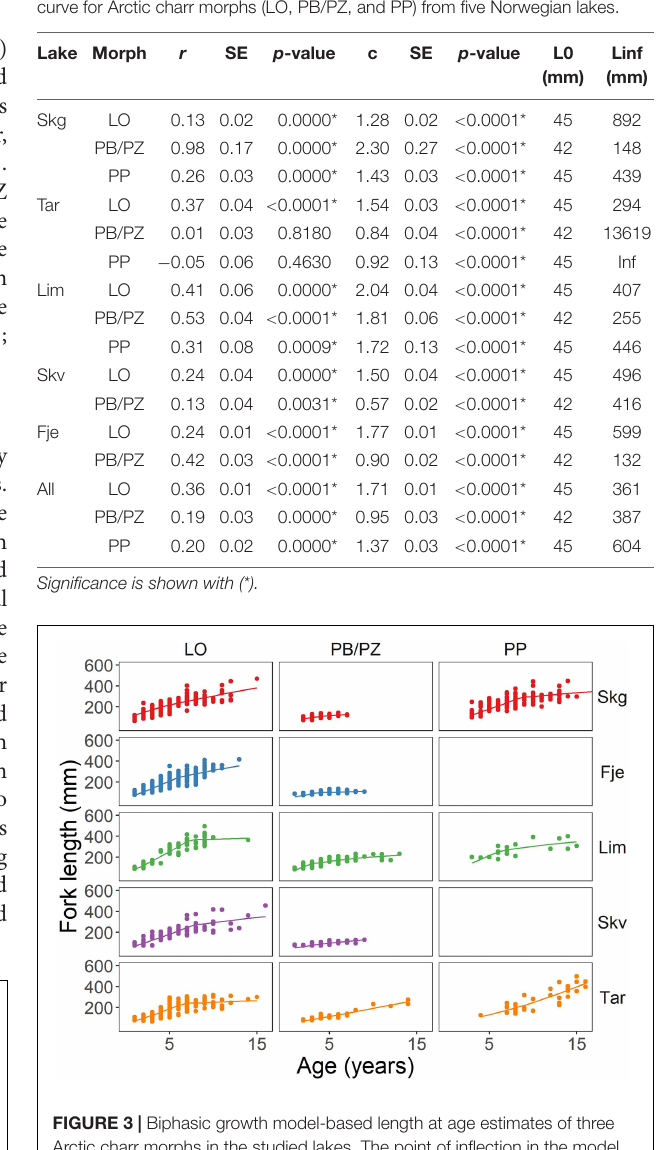
TABLE 2 | Estimated coefficients and their standard error for parameters r and c of the biphasic growth model along with the L 0 value used the estimating of each curve for Arctic charr morphs (LO, PB/PZ, and PP) from five Norwegian lakes.